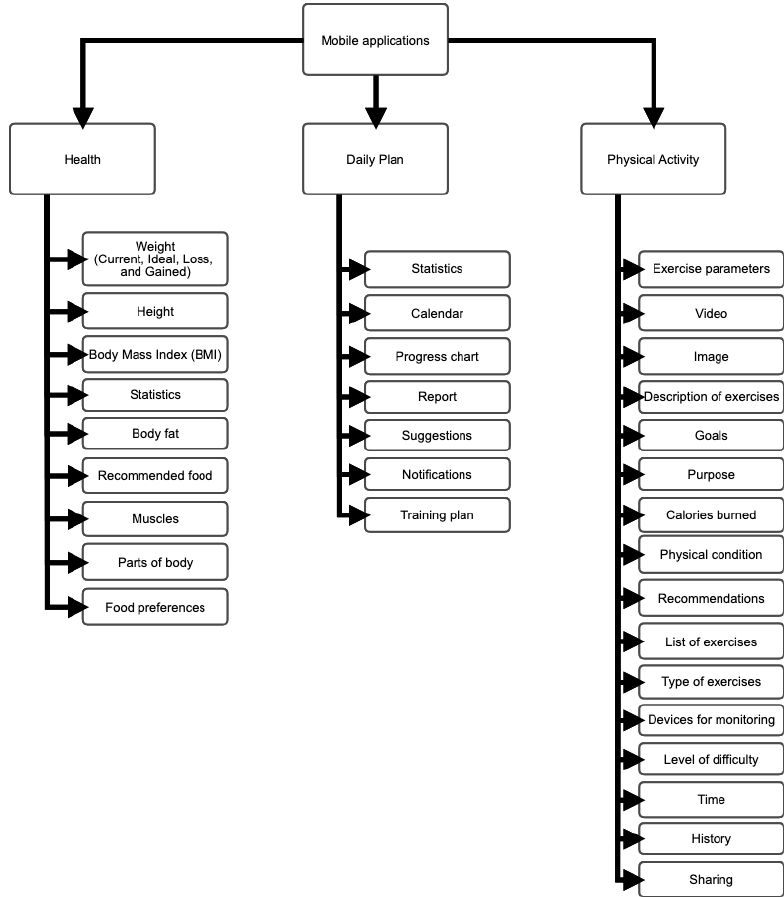
Figure 4. Taxonomy of the features of mobile applications for personal